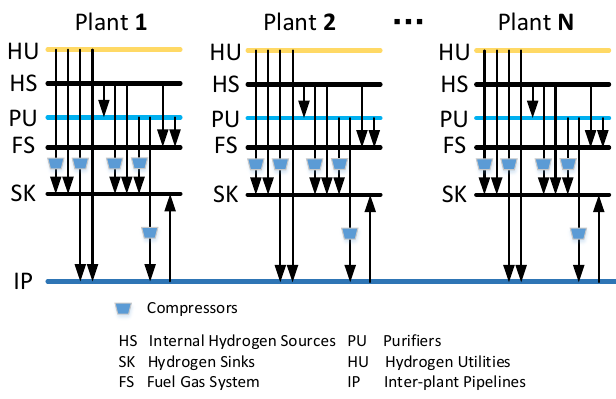
Figure 1. The superstructure of the inter-plant hydrogen network.